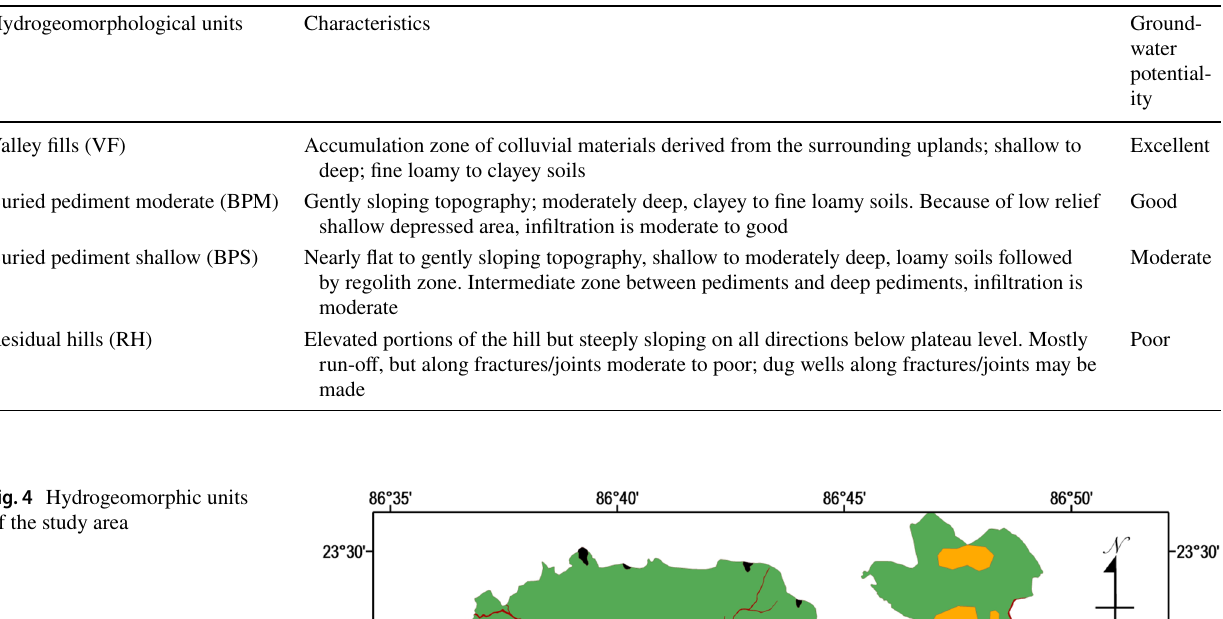
Table 2 Different hydrogeomorphic units, their characteristic features along with groundwater potentiality Hydrogeomorphological units